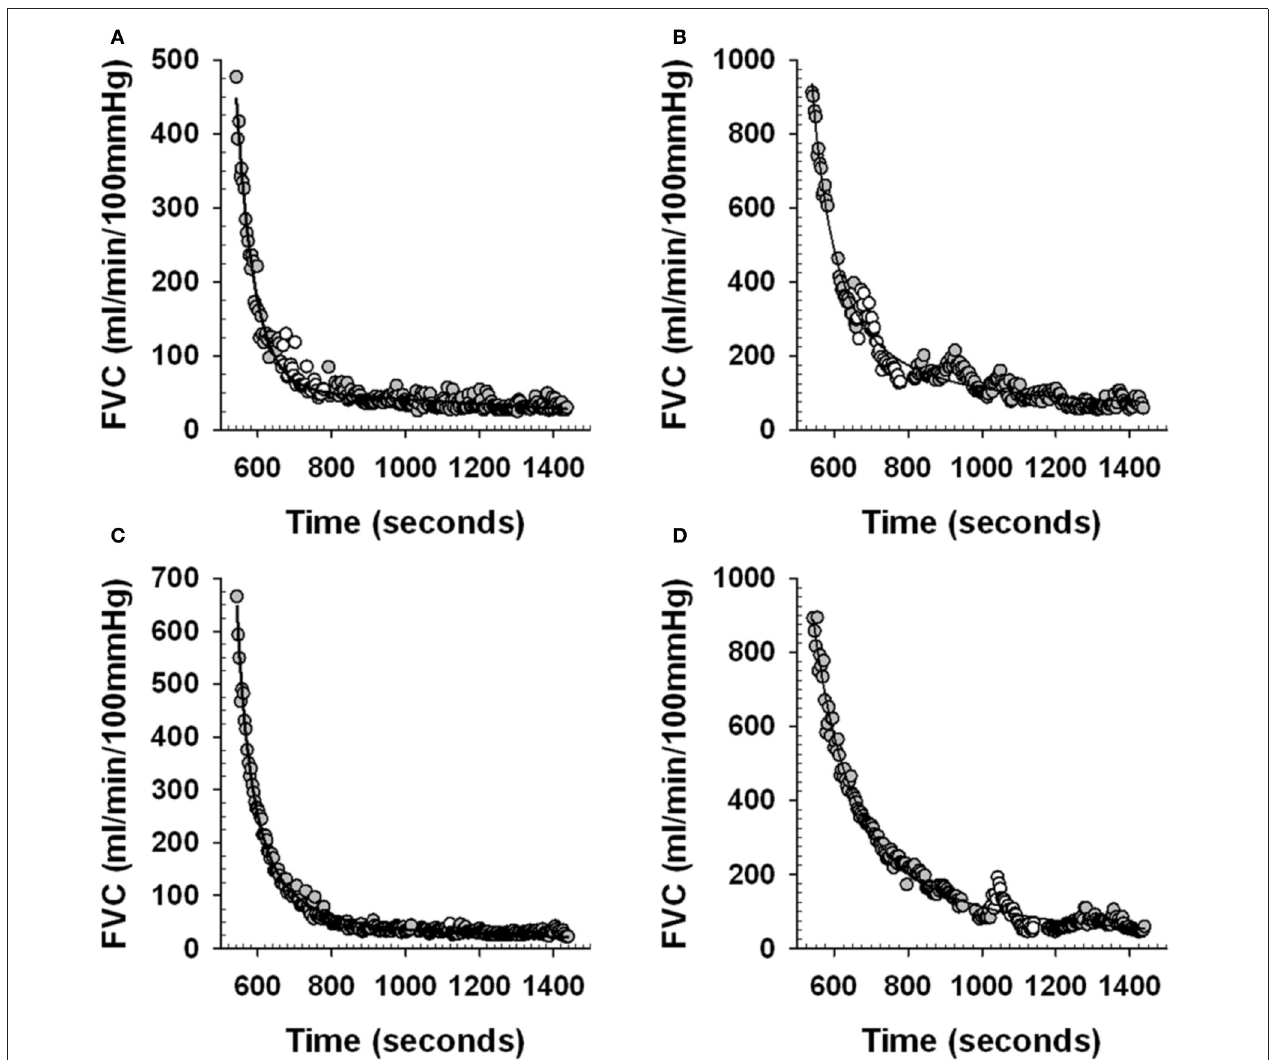
Panels (B) and (D) examples of individual subject beat-by-beat post-exercise FVC responses during a PE early and PE late trial respectively (see Figure 1 ). White circles represent the beat-by-beat FVC data that is removed during the curve fitting to allow curve fit estimation of what FVC would have been without the CPT. Gray circles represent the beat-by-beat FVC data that is curve fit. Solid line is the curve